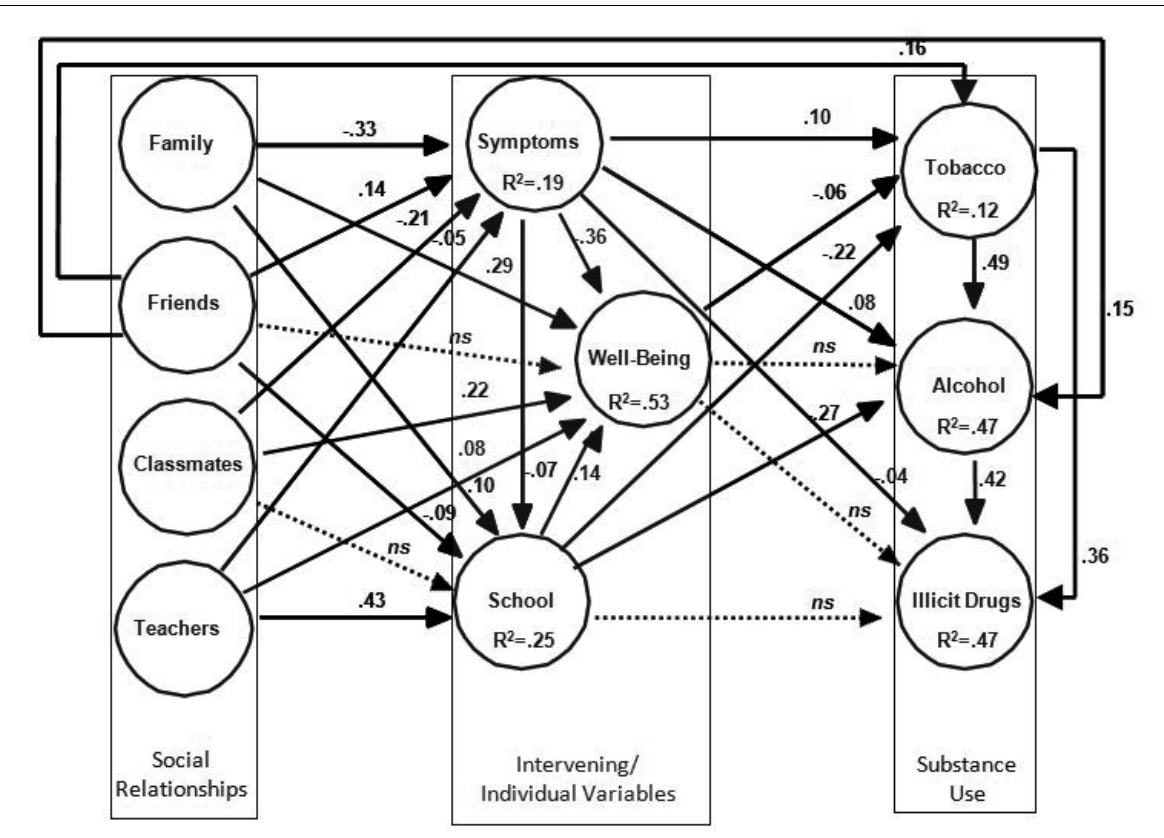
Figure 1 . Substance use explanatory model with the full sample, N =12881. Note. Only structural paths are represented in the fi